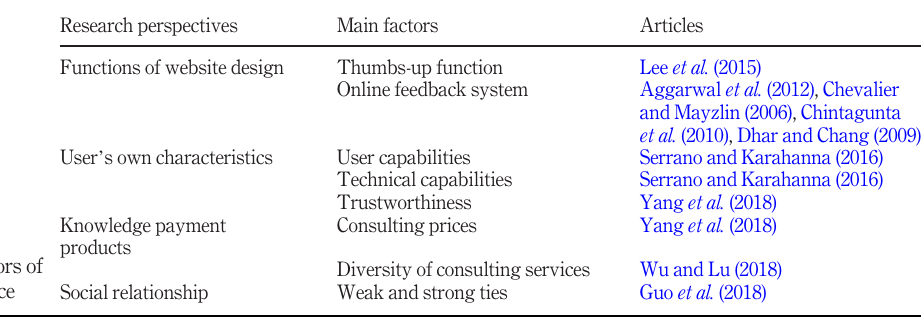
Table III. In fl uencing factors of sales